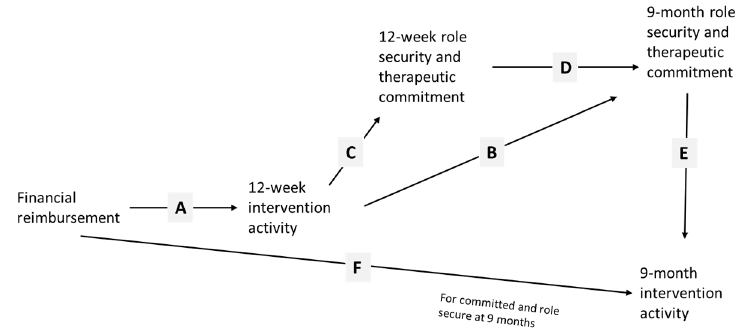
Figure 2. Hypothesized path model for financial reimbursement.